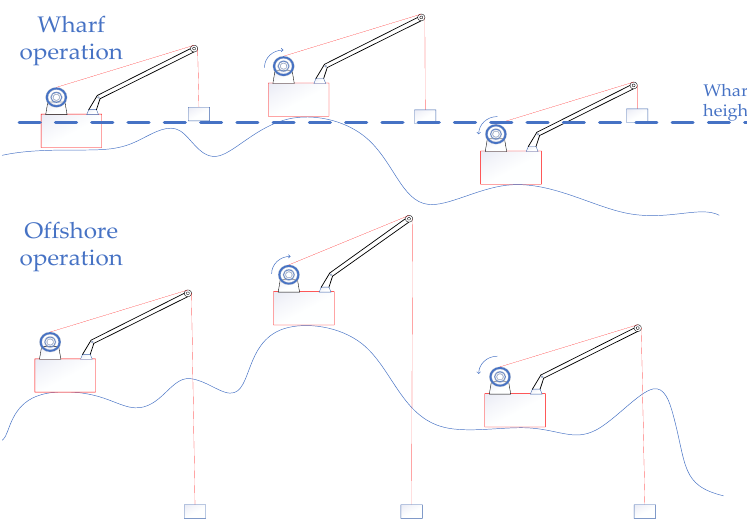
Figure A1. The movement form of the compensation system.